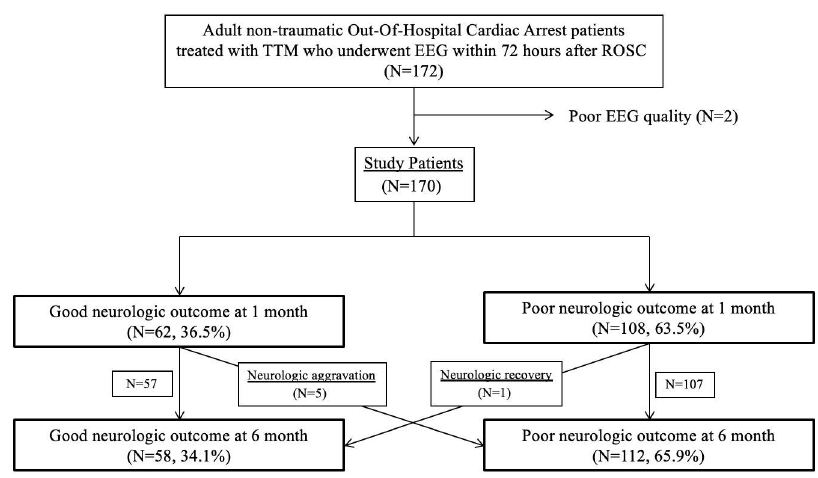
Figure 2. Patient flow diagram. Abbreviations: targeted temperature management (TTM); electroencephalography (EEG); return of spontaneous circulation (ROSC).